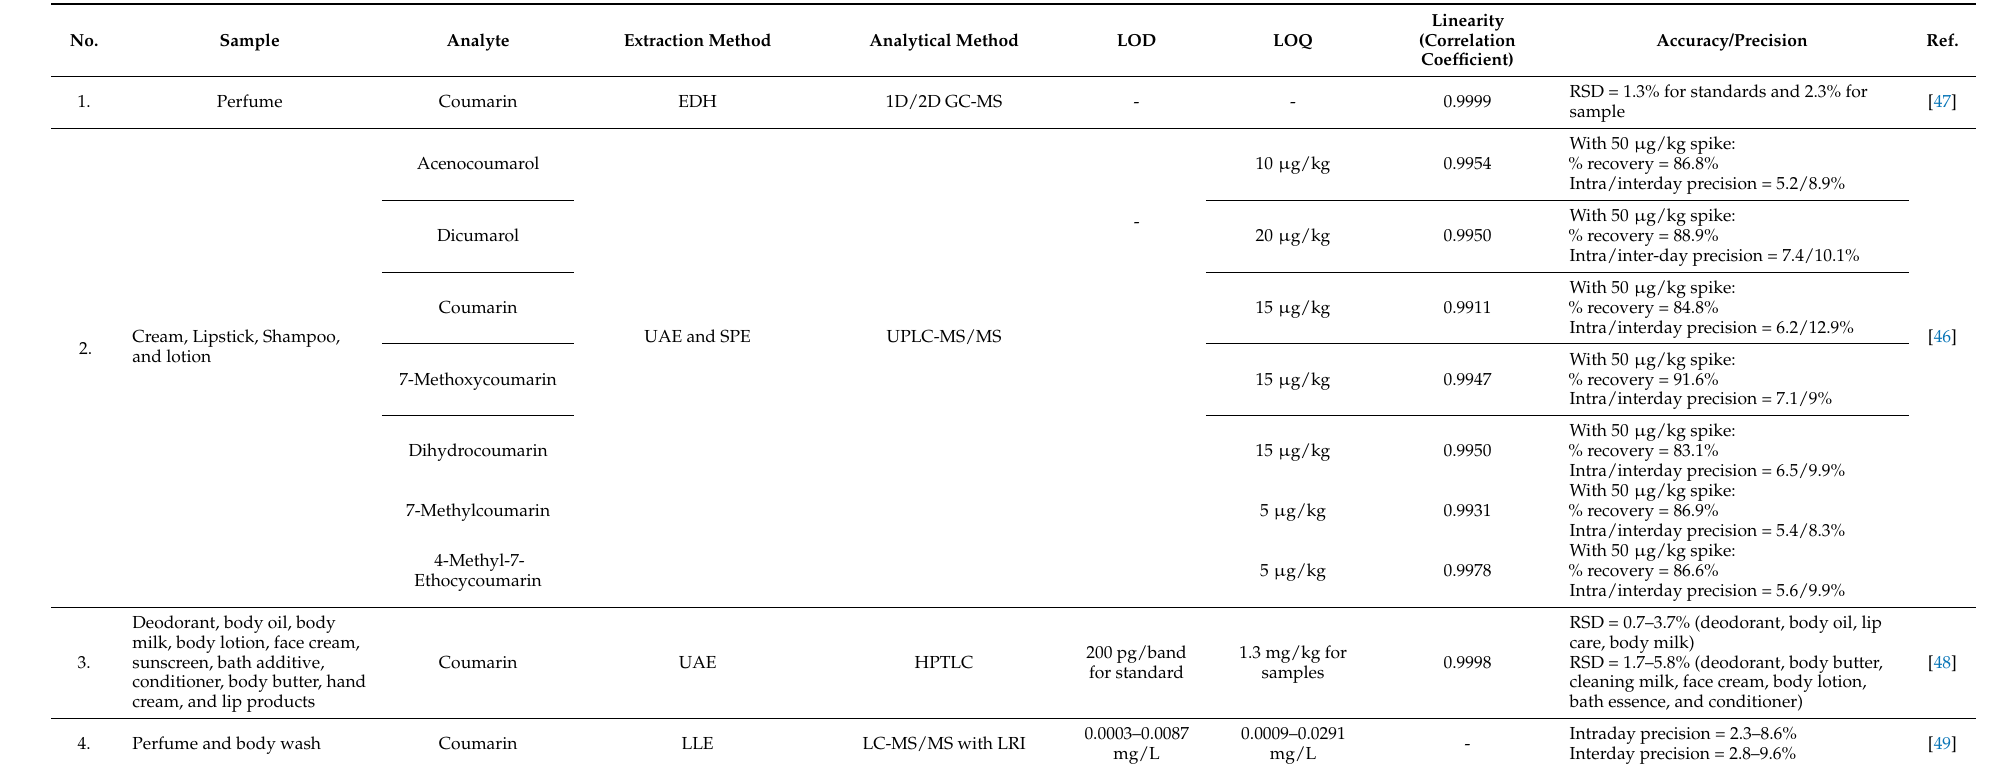
Table 8. Analytical methods for determining coumarin in